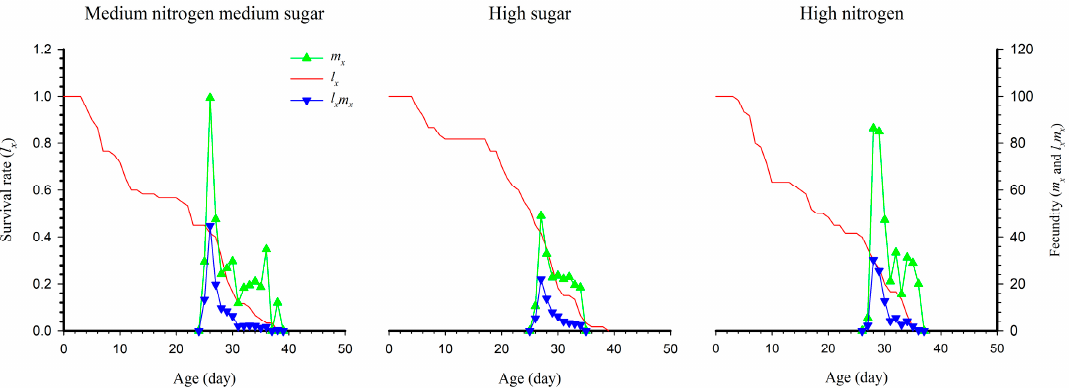
Figure 2. The age-specific survival rate ( l x ), fecundity ( m x ) and net maternity ( l x m x ) of S. exigua under three nutritional conditions.